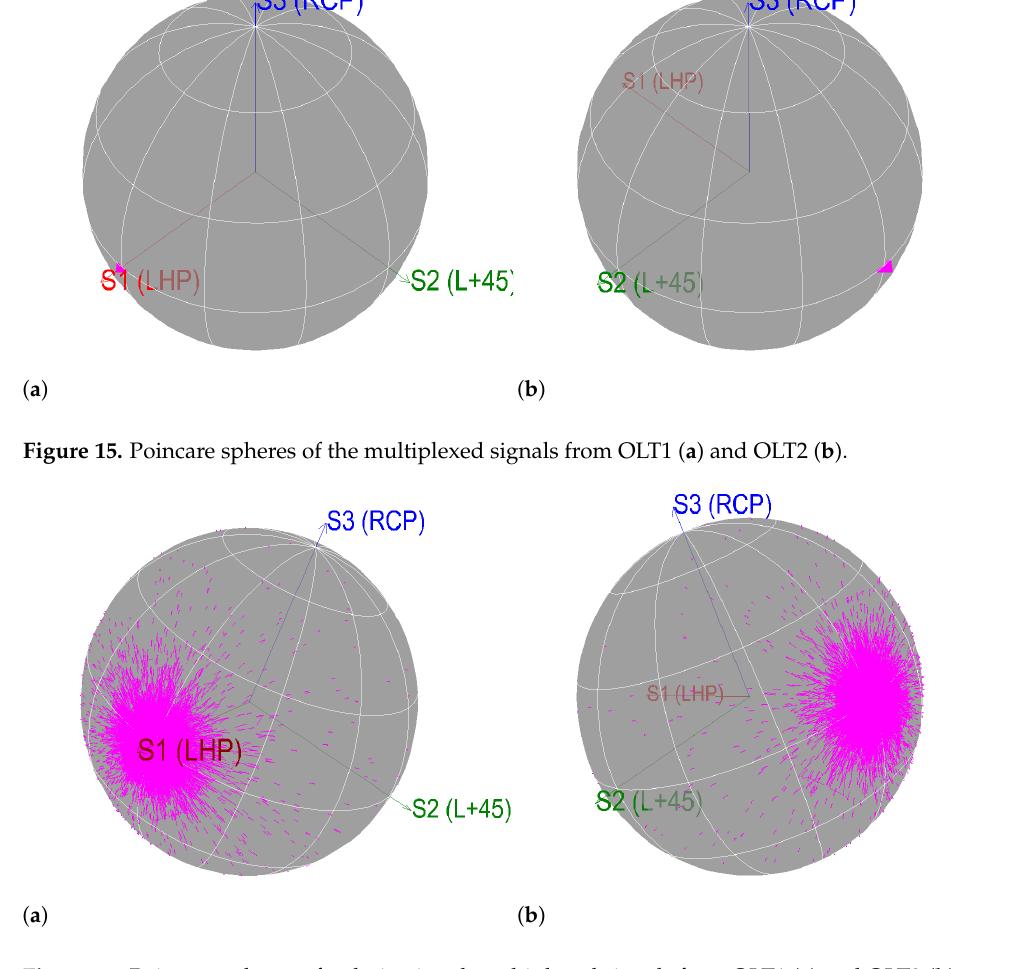
Figure 16. Poincare spheres of polarization demultiplexed signals from OLT1 ( a ) and OLT2 ( b